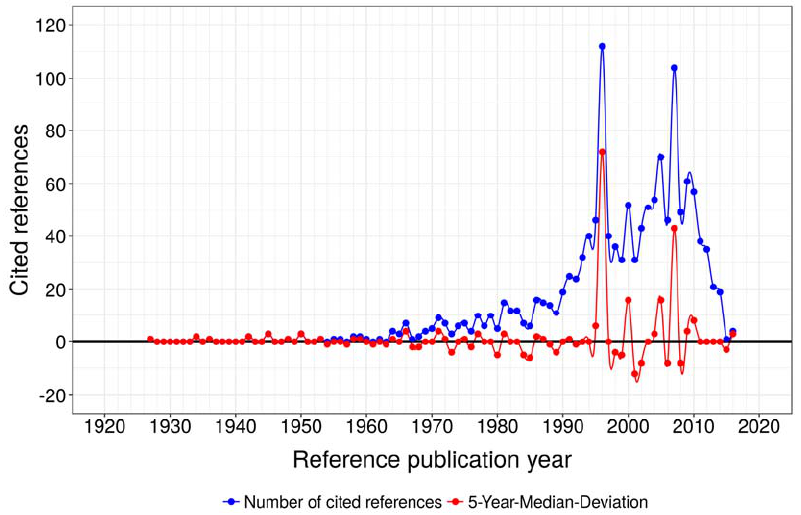
Figure 3. Annual distribution of the cited references, which are co-cited with the seminal 1996 paper by Wijeratne [5], across their reference publication years 1927–2016. Blue curve: number of cited references; red curve: deviation from the median.